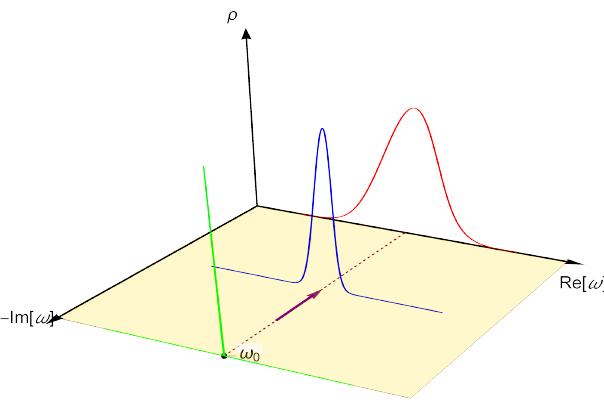
Figure 7 . Schematic diagram to illustrate the connection between the QNM frequency and the spectral